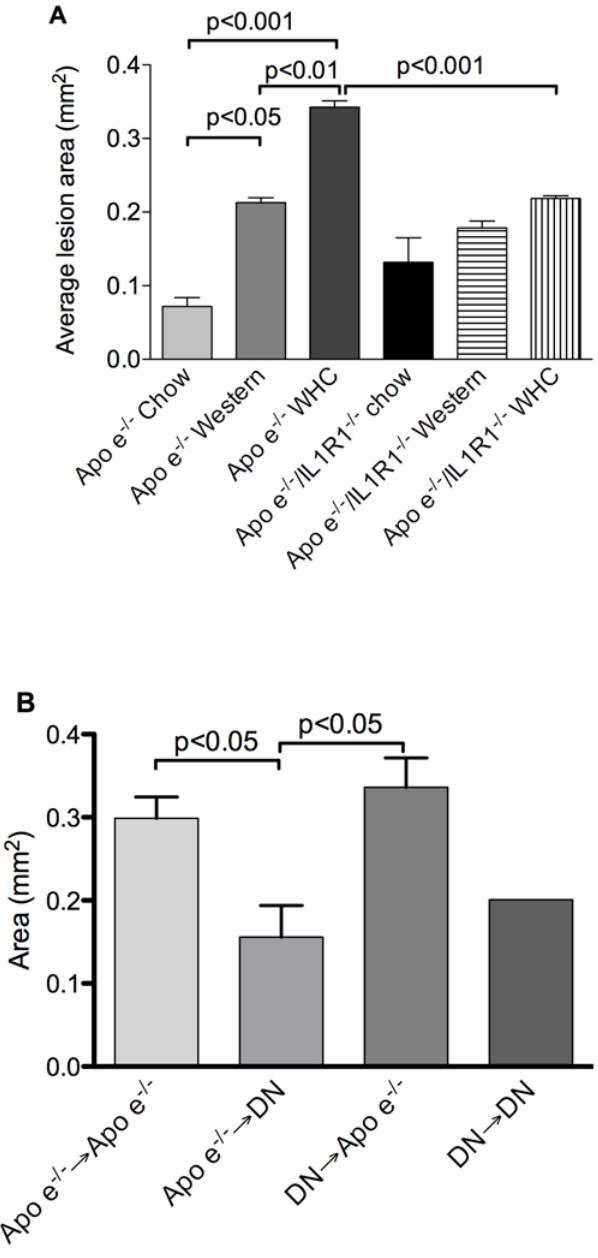
Figure 1. Atherosclerosis formation in mice following feeding of a high fat diet. Atherosclerotic lesion area in the aortic sinus of Apoe 2 / 2 and Apoe 2 / 2 /IL-R1 2 / 2 mice (a) and chimeric mice (b) fed a high fat and chow diets. Apoe R DN denotes Apoe 2 / 2 / IL-1R1 2 / 2 (DN) mice receiving Apoe 2 / 2 bone marrow (n=3); DN R Apoe denotes Apoe 2 / 2 mice receiving Apoe 2 / 2 / IL-1R1 2 / 2 marrow